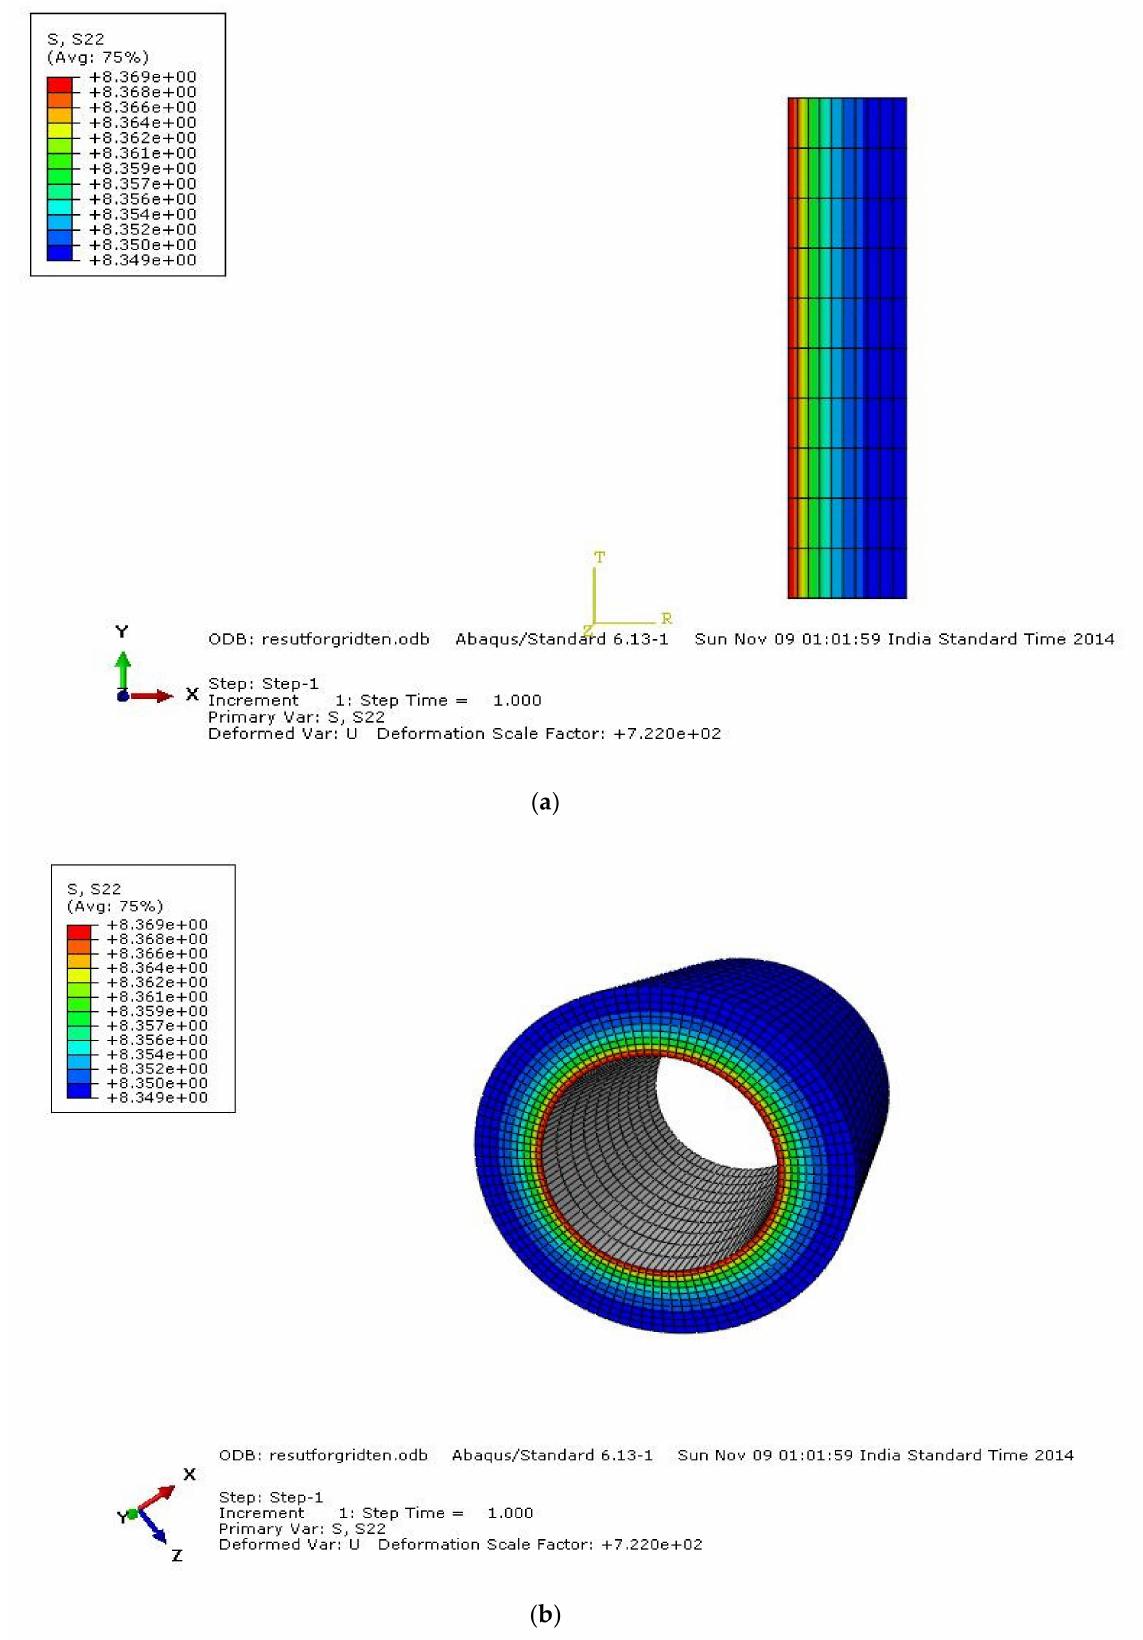
Figure 6. Analysis on sweep of axial stress elements: ( a ) before, ( b )